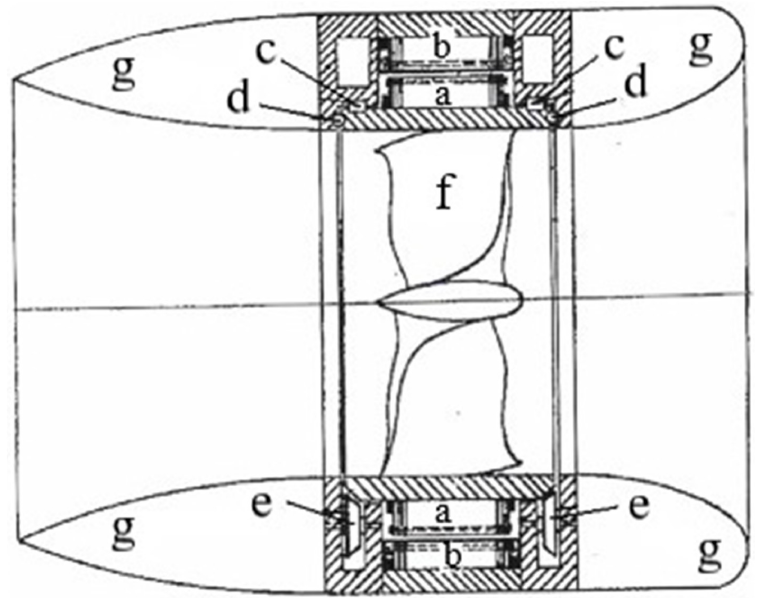
Figure 5. The earliest patent of IMP: ( a ) rotor; ( b ) stator; ( c ) bearings; ( d ) bearings; ( e ) bearings and attachment; ( f ) propeller; and ( g ) duct [10].